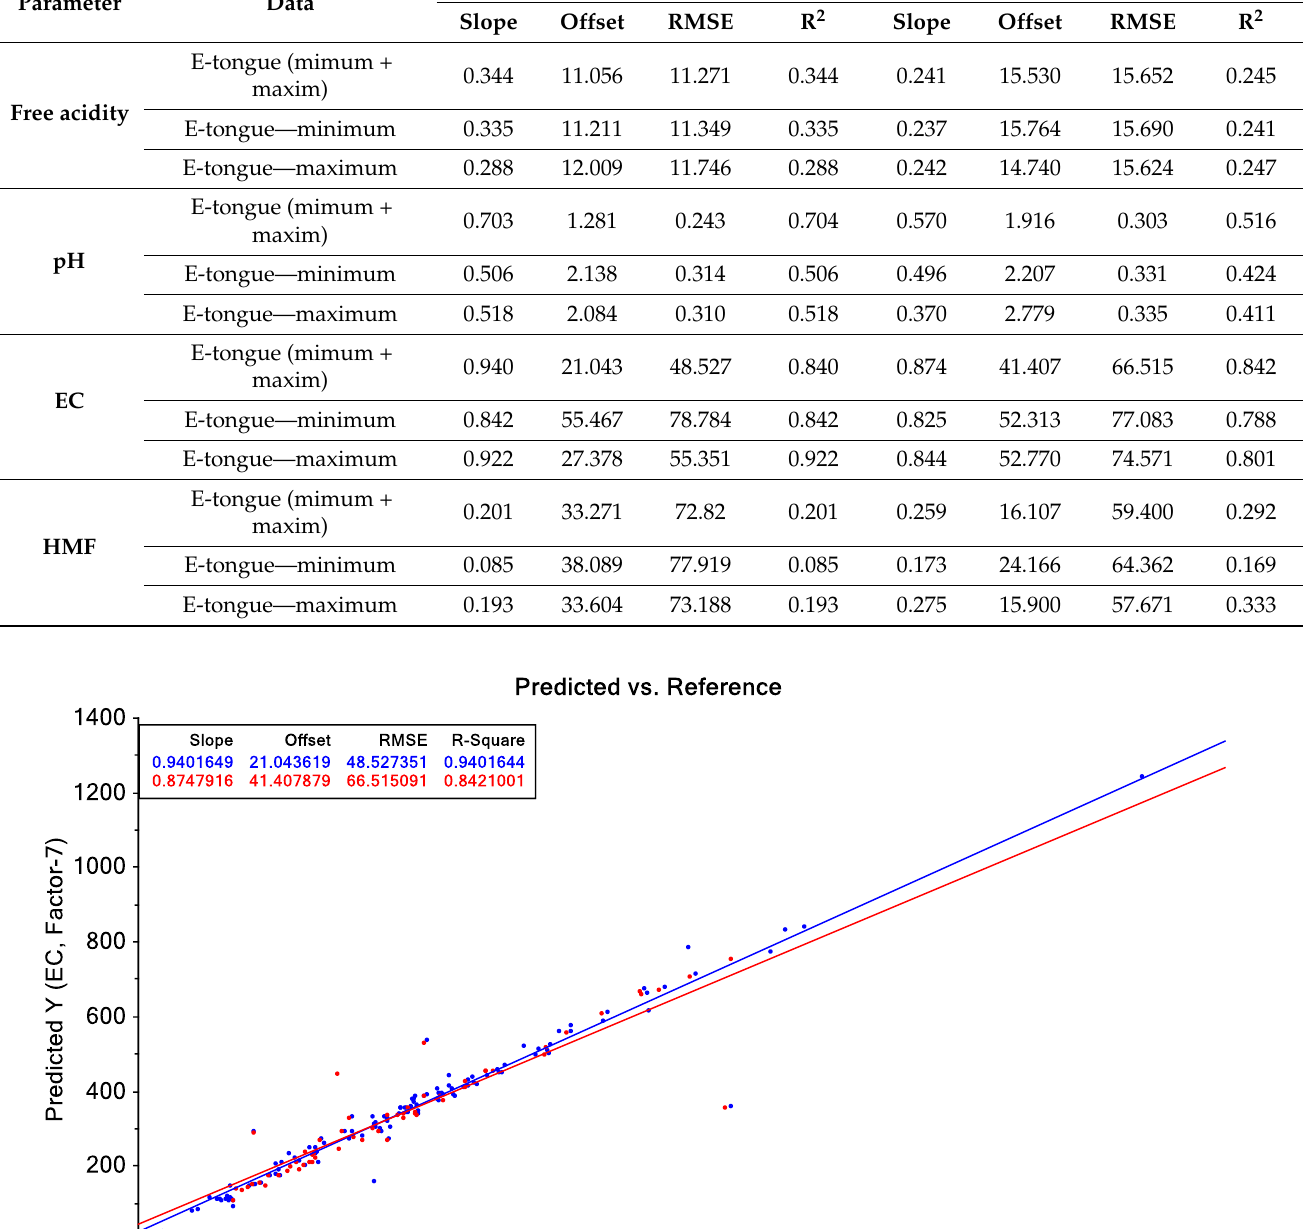
Table 3. Regression parameters of the calibration and validation procedure calculated for the e-tongue data submitted to partial least square regression (PLS-R) analysis.